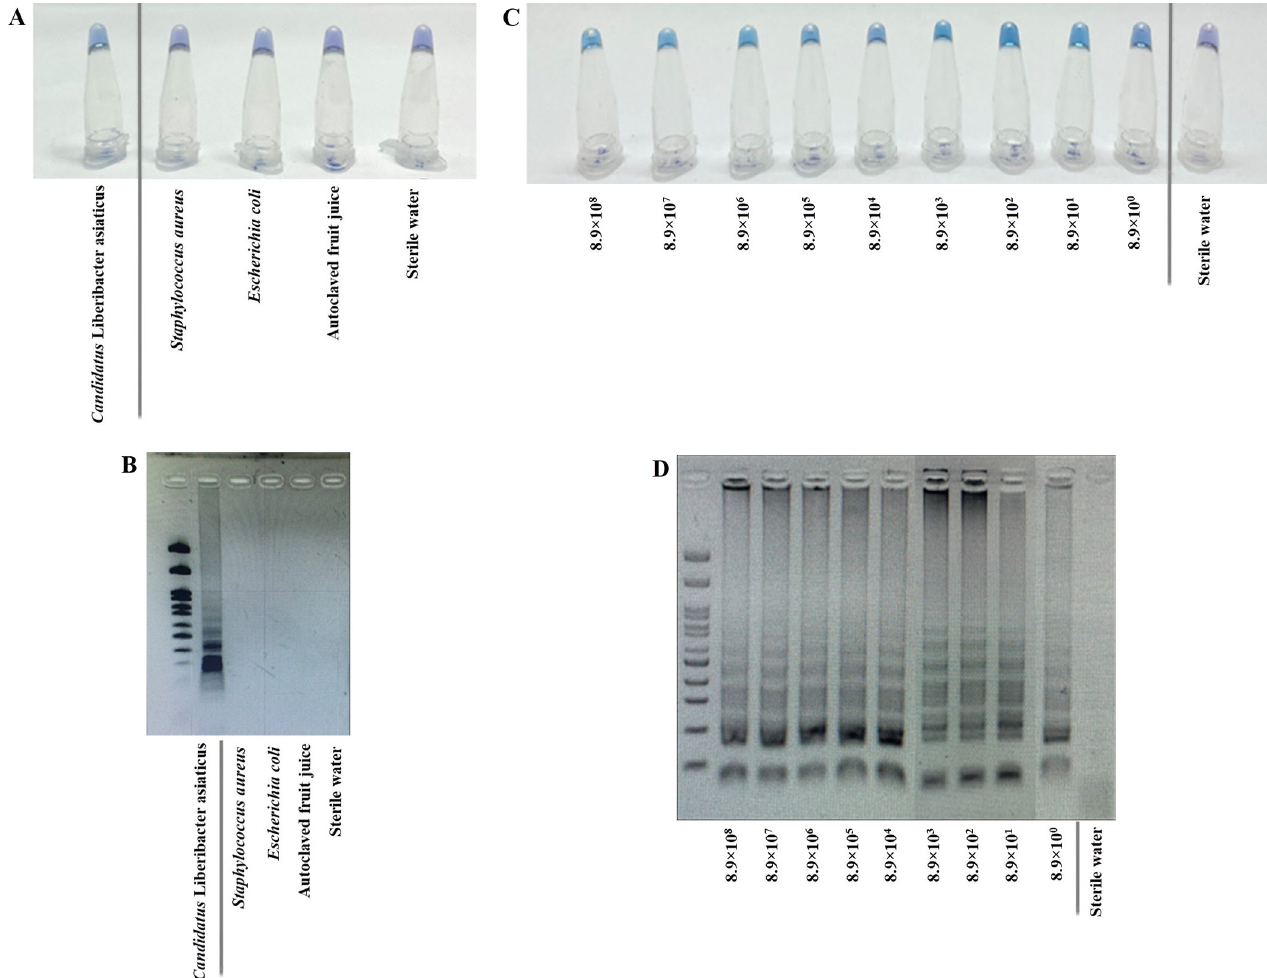
Fig 1. Specificity and sensitivity determination of our developed methods by LAMP-HNB (A and C) and LAMP-GE (B and D). Specificity assay ( A and B ) included positive ( C . Liberibacter asiaticus) and negative ( Staphylococcus aureus , Escherichia coli , autoclaved ( Citrus ) fruit juice, and sterile water) controls. Sensitivity assay ( C and D ) included 8.9 × 10 8 to 8.9 × 10˚ copy numbers (equaling 1.0 ng to 0.01 fg) of omp from C . Liberibacter asiaticus and sterile water. In B and D , the first left lane was OneMARK 100 DNA ladder (Bio-Helix), and a positive LAMP reaction showed characteristic multiple ladder-like bands due to intercalating multiple loops of the LAMP product. Further limits of detection of LAMP-HNB, LAMP-GE, and PCR-GE assays at 5 and 1 copy numbers of omp are in S3 Fig.